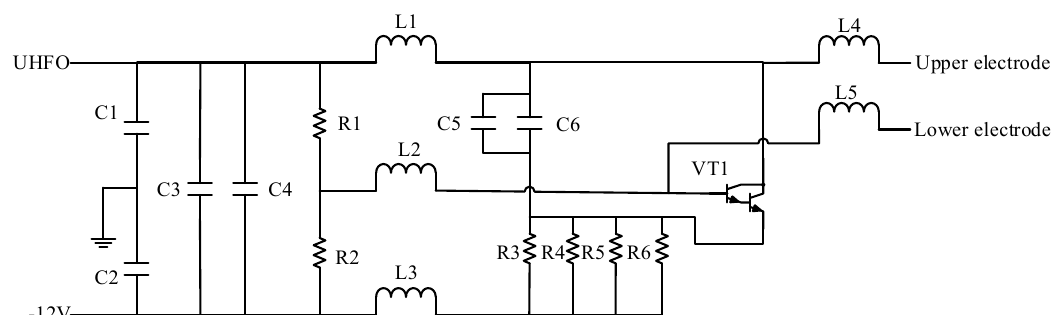
Sensors 2019 , 19 , x FOR PEER REVIEW Figure 2. Temperature acquisition circuit. Figure 2. Temperature acquisition circuit.